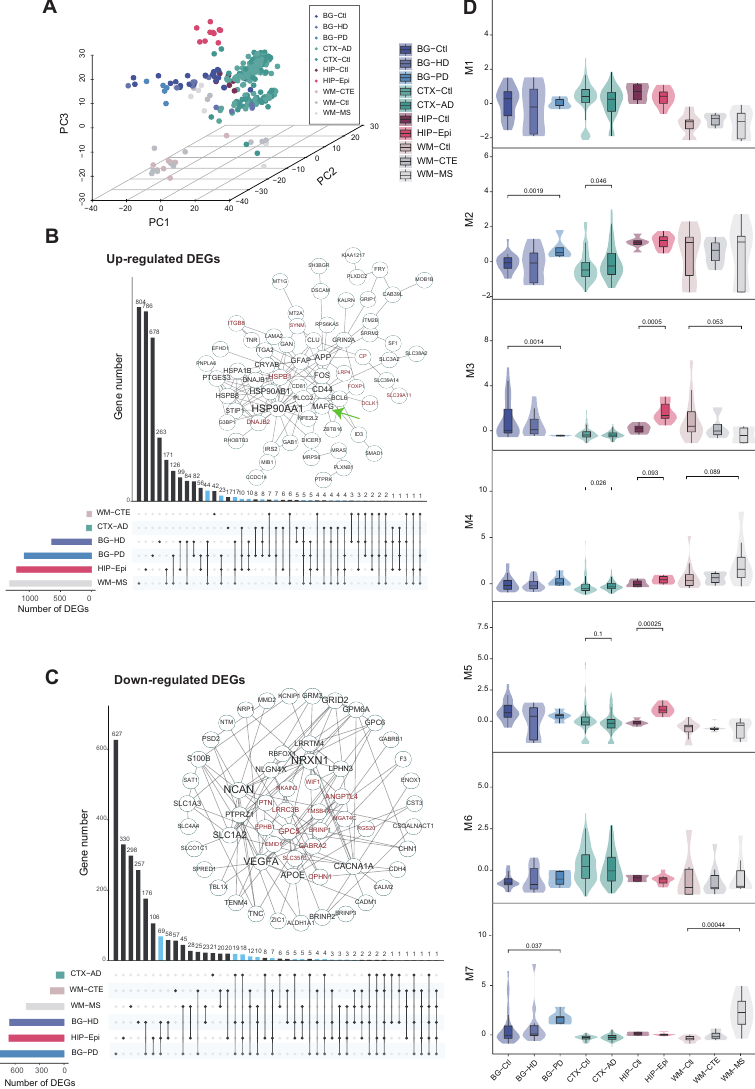
Figure 5. Gene and modular transcriptomic changes across multiple CNS disorders and brain regions. ( A ) Three-dimensional PCA plot for different CNS disorder samples based on disease-associated genes. Samples are grouped by both brain region and disease condition: basal ganglion control (BG- Ctl, N = 24), basal ganglion Huntington’s disease (BG-HD, N = 11), basal ganglion Parkinson’s disease (BG-PD, N = 5), cortex Alzheimer’s disease (CTX-AD, N = 120), cortex control (CTX-Ctl, N = 89), hippocampus control (HIP-Ctl, N = 6), hippocampus epilepsy (HIP-Epi, N = 10), white matter control (WM-Ctl, N = 13), white matter chronic traumatic encephalopathy (WM-CTE, N = 8); white matter multiple sclerosis (WM-MS, N = 8). ( B ) UpSet plot showing unique and overlapping up-regulated DEGs for each CNS disorder. The inset panel demonstrates interaction networks among collectively up-regulated genes in at least three out of six disorders. DEGs in at least four out of six disorders are colored in red. ( C ) A similar analysis for down-regulated DEGs across CNS disorders. ( D ) Boxplots showing the distribution of module scores in all control and disorder groups as described in ( A ). p -values are derived from a two-sided Wilcoxon